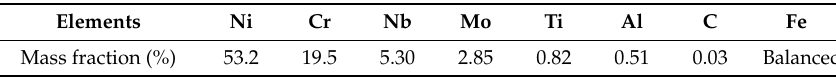
Table 1. Chemical compositions of the as-received GH4169